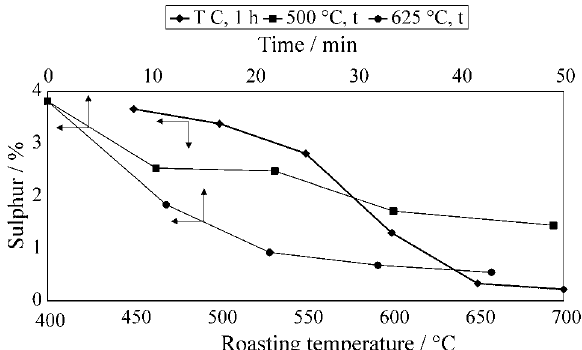
Figure 8. Sulphur in the products roasted under different conditions.